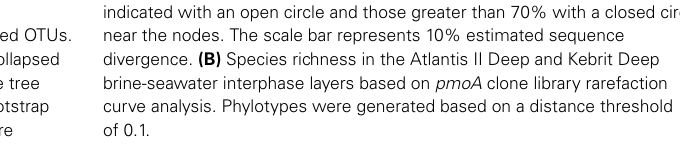
Table 4 | Comparison of the sMMO and pMMO reads obtained from the brine-seawater interfaces. Sample